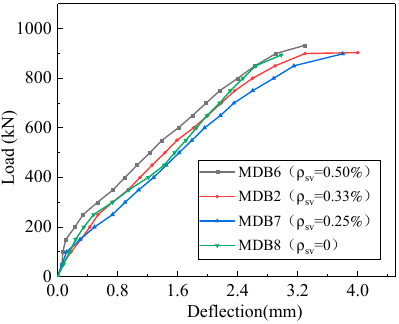
Figure 17. Relation curve between ρ sv and load.